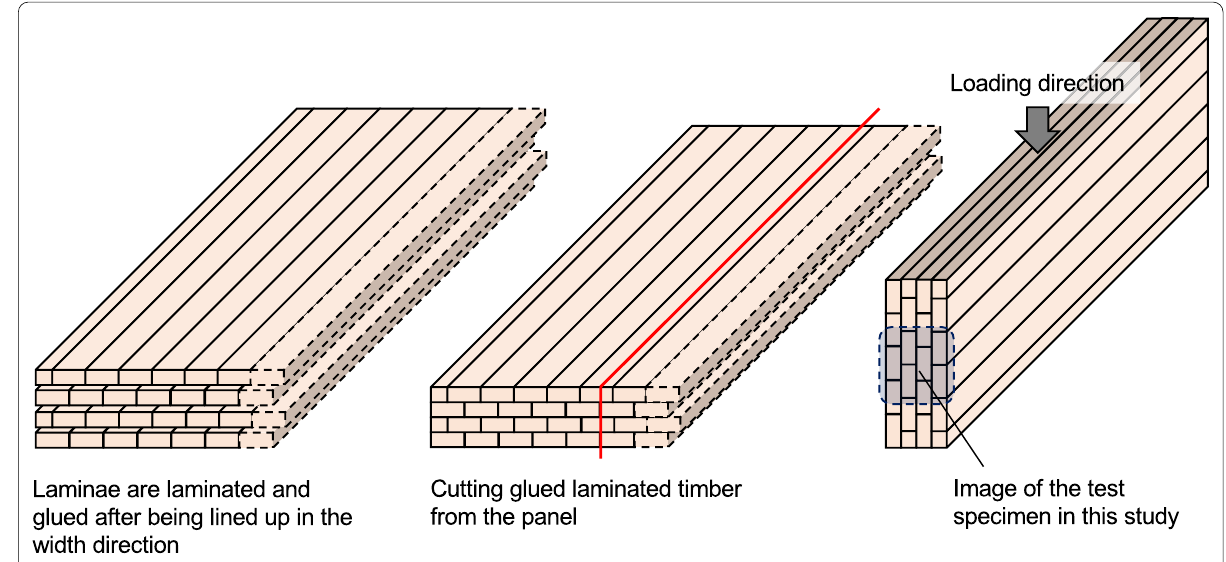
Fig. 1 Schematic image of the production of the glued laminated timber assumed in this